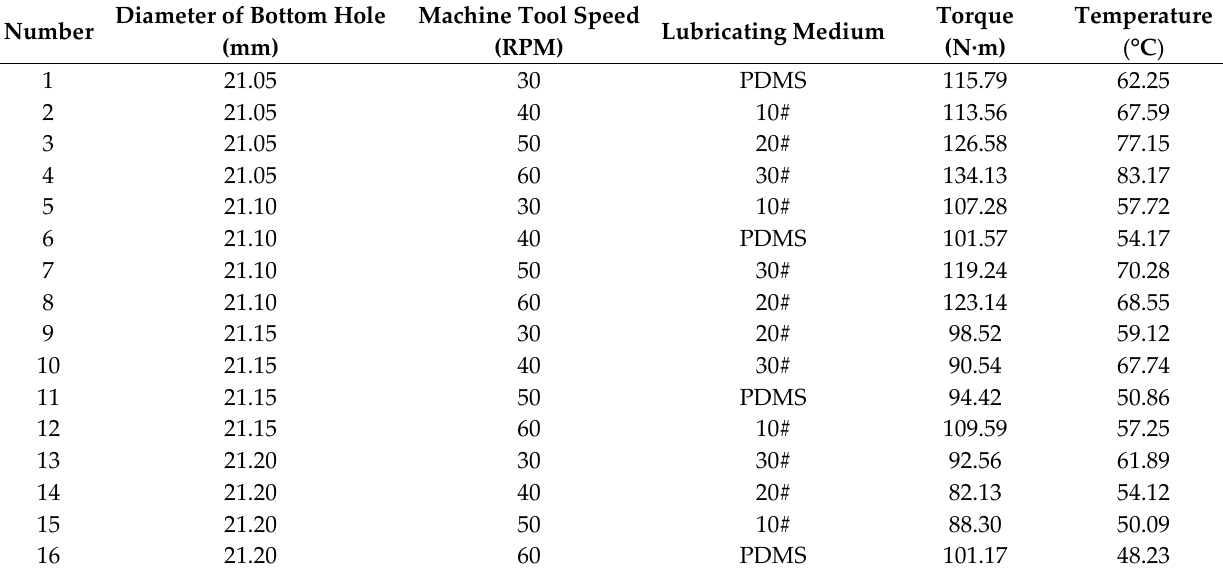
Table 3. Orthogonal design of processing